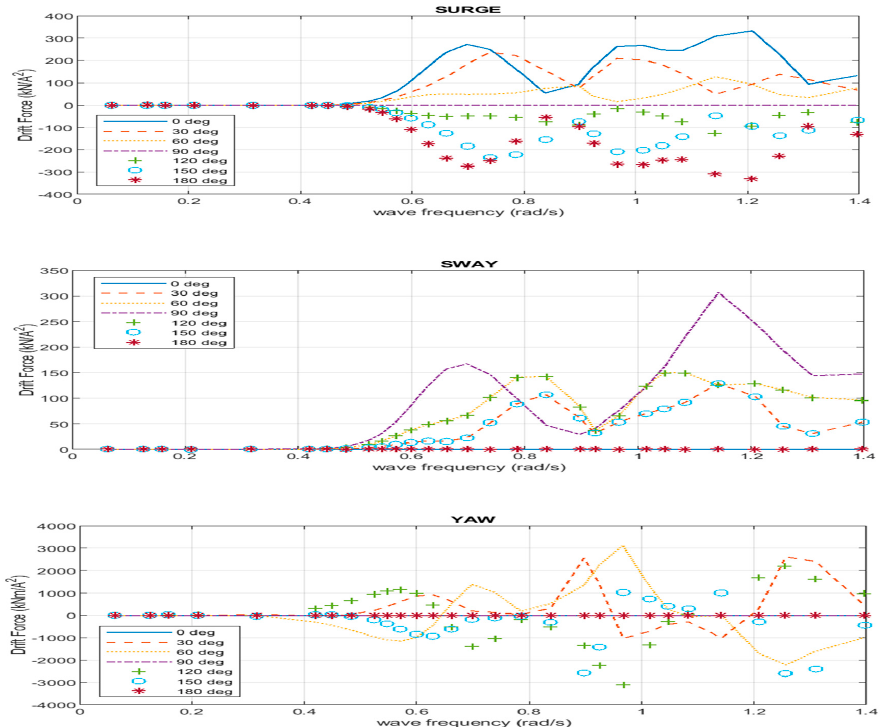
Figure 5. First-Order wave loads.